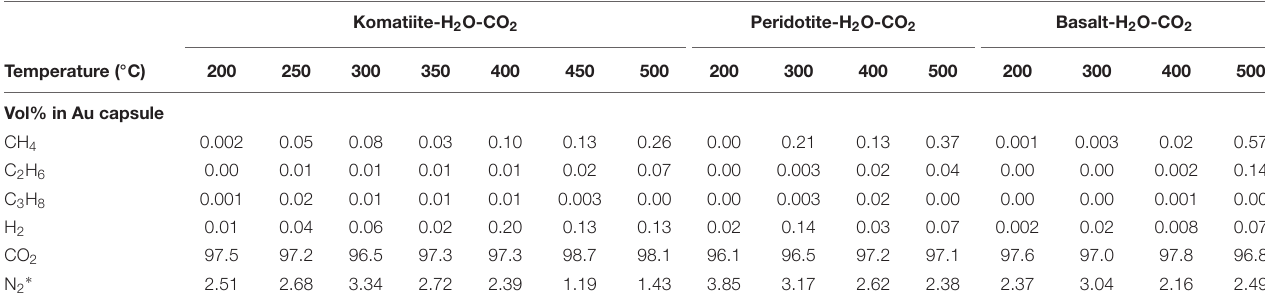
FIGURE 1 | Schematic diagram of the gas collection system connected with GC. After the sealed Au capsule was cleaned and put into the gas-collection system. Valve B was closed while valves A, C, and D were open. The whole system was evacuated by the vacuum pump. Then the Au capsule was pierced by the needle on top of it to release the sealed volatile components which would then fill the space entrapped by valves A, B, and D. Finally, valve D was open to allow the gasses to be analyzed by the 6890N GC. TABLE 2 | GC measurements of hydrogen and light alkanes produced in the batch